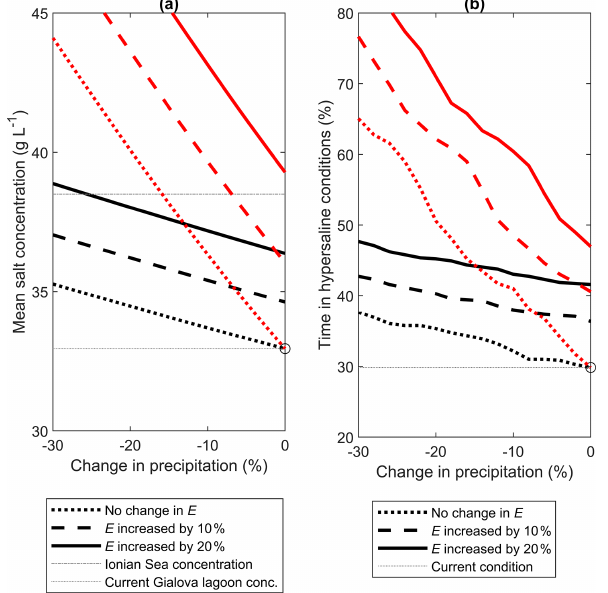
Figure 7. Effect of changes in freshwater input on (a) the mean salt concentration in the Gialova lagoon and (b) the percentage of time under hypersaline conditions, under different climatic scenar- ios (different line styles; see details in Table 2). Percentage time is calculated for the two simulation years; for visual reference, the grey horizontal dotted lines indicate current salinity and duration of hypersaline conditions in the Gialova lagoon, and the grey dotted– dashed line in (a) indicates salt concentration in the Ionian Sea as of today; current conditions are indicated by open